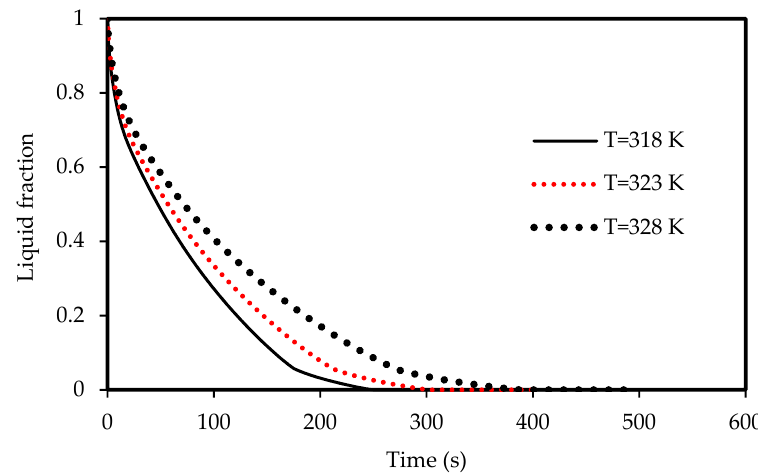
Figure 23. Evolution of the liquid-fraction for the solidification process in the horizontal corrugated channel for different airflow temperatures.